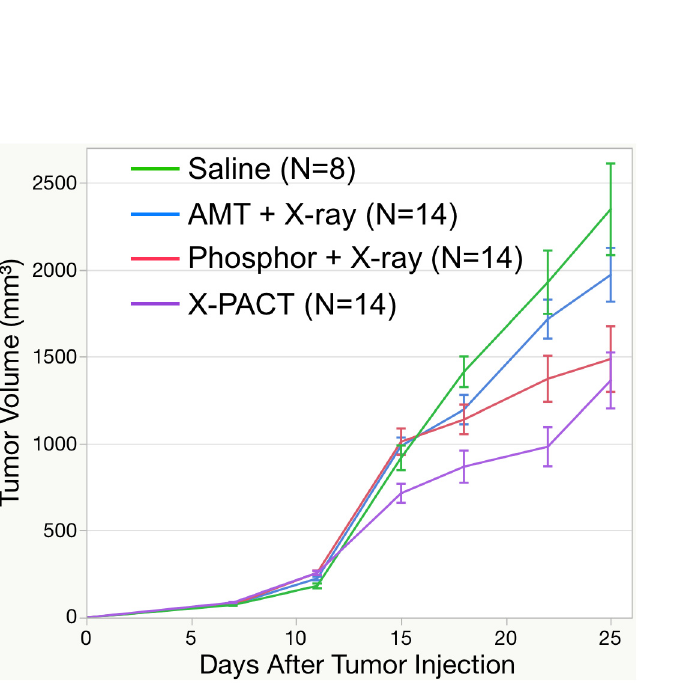
Fig 6. In-vivo investigation of X-PACT application to BALB/c mice with syngeneic 4T1-HER2 tumors. Error bars are 1 standard error of the mean. A generalized linear model that used an autoregressive correlation structure to account for within-mouse correlations showed the rate of tumor growth after initiation of treatment to differ significantly among the 4 groups (p < 0.0001; interaction between time and group). The rate of tumor growth within the phosphor + X-ray and X-PACT groups was significantly slower than that observed in the saline (p < 0.0001 and p < 0.0001, respectively) and AMT + X-ray groups (p = 0.0073 and p = 0.0011,